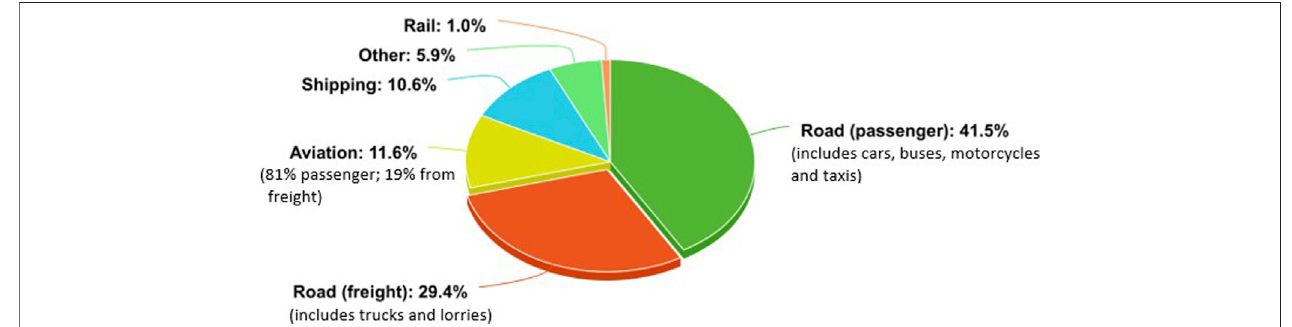
FIGURE 1 | Breakdown of global CO 2 emissions per transport